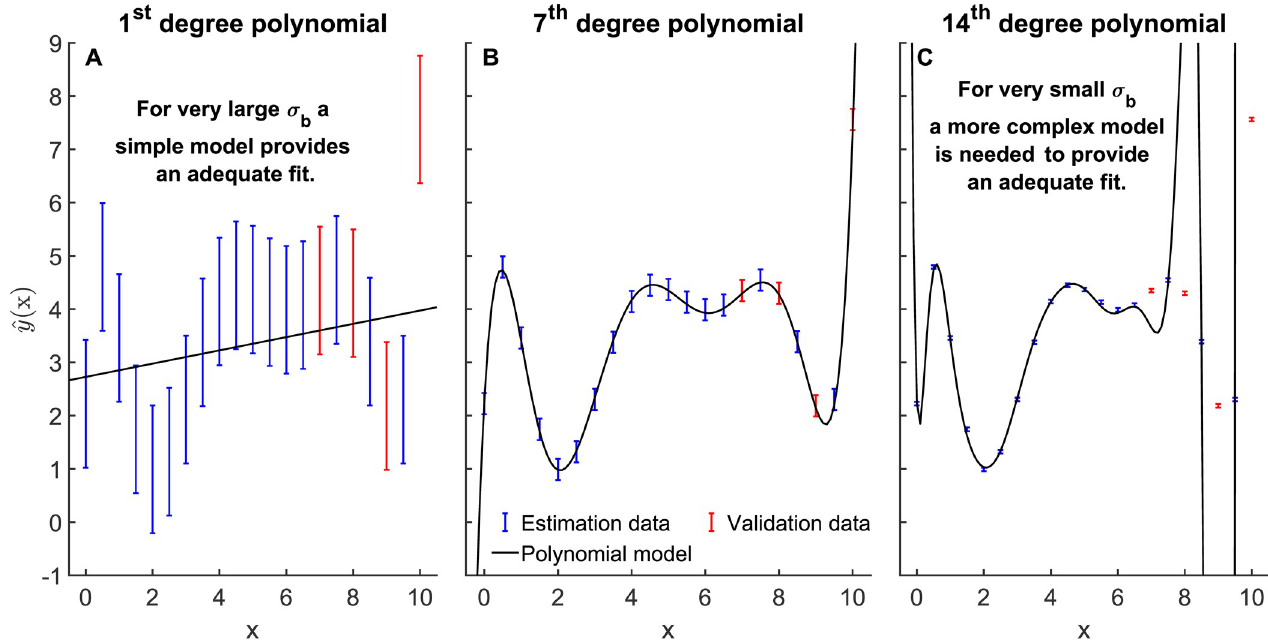
Fig 3. Example of how model selection is affected by σ b , for the polynomial model. Error bars indicate data sampled from a 7 th order polynomial y = h 7 (x, u 0 ) + � where � is N(0, σ r ), σ r = 0.2. Colours indicate estimation data D est (blue) and validation data D val (red) used by the “Validation” method. Solid curves in (A– B) indicate polynomials chosen by an estimation-based method with different “believed” standard deviation σ b . (A) σ b = 2, chosen model h 1 . (B) σ b = 0.2 (the true value), chosen model h 7 (the correct model). (C) σ b = 0.02, chosen model h 14 .